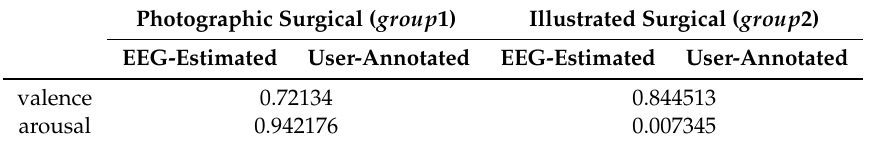
Table 4. p values for t -test between EEG-estimated and user-annotated valence and arousal.